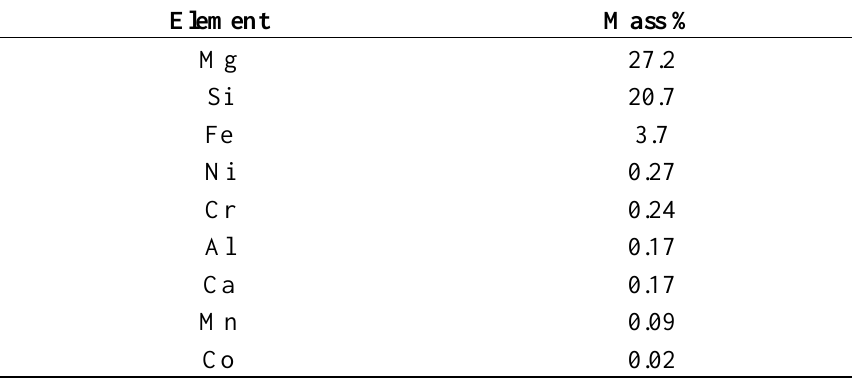
Table 1. Elemental composition of fresh olivine, in decreasing order, determined